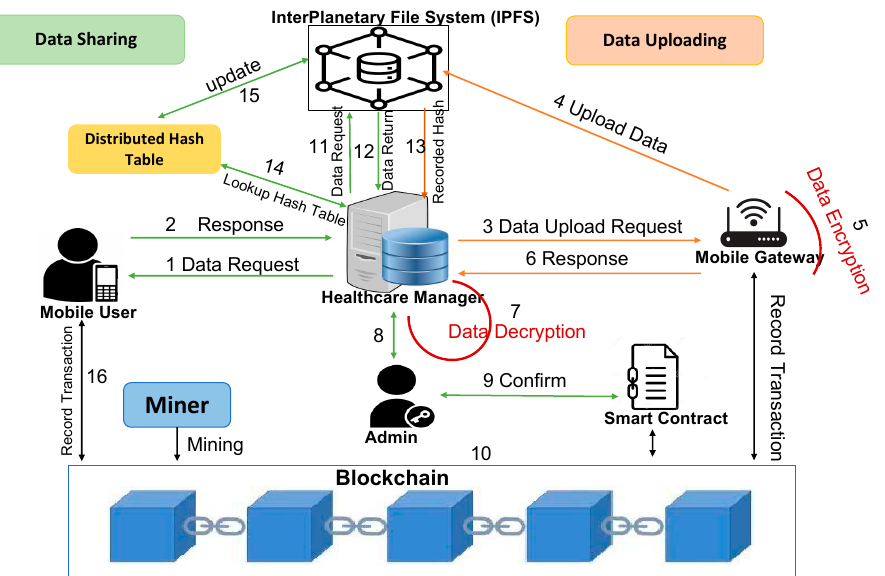
Figure 3. Design of the Data Flow Model.